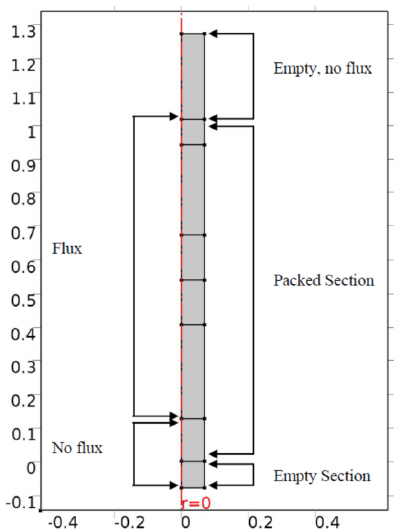
Figure 3. Two-dimensional representation of N = 5.45 packed bed for dispersion models.